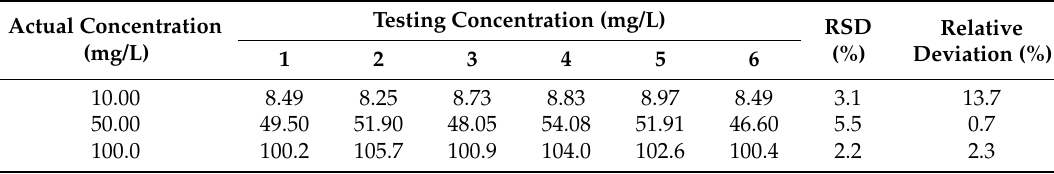
Table 4. Accuracy of UV spectrophotometry